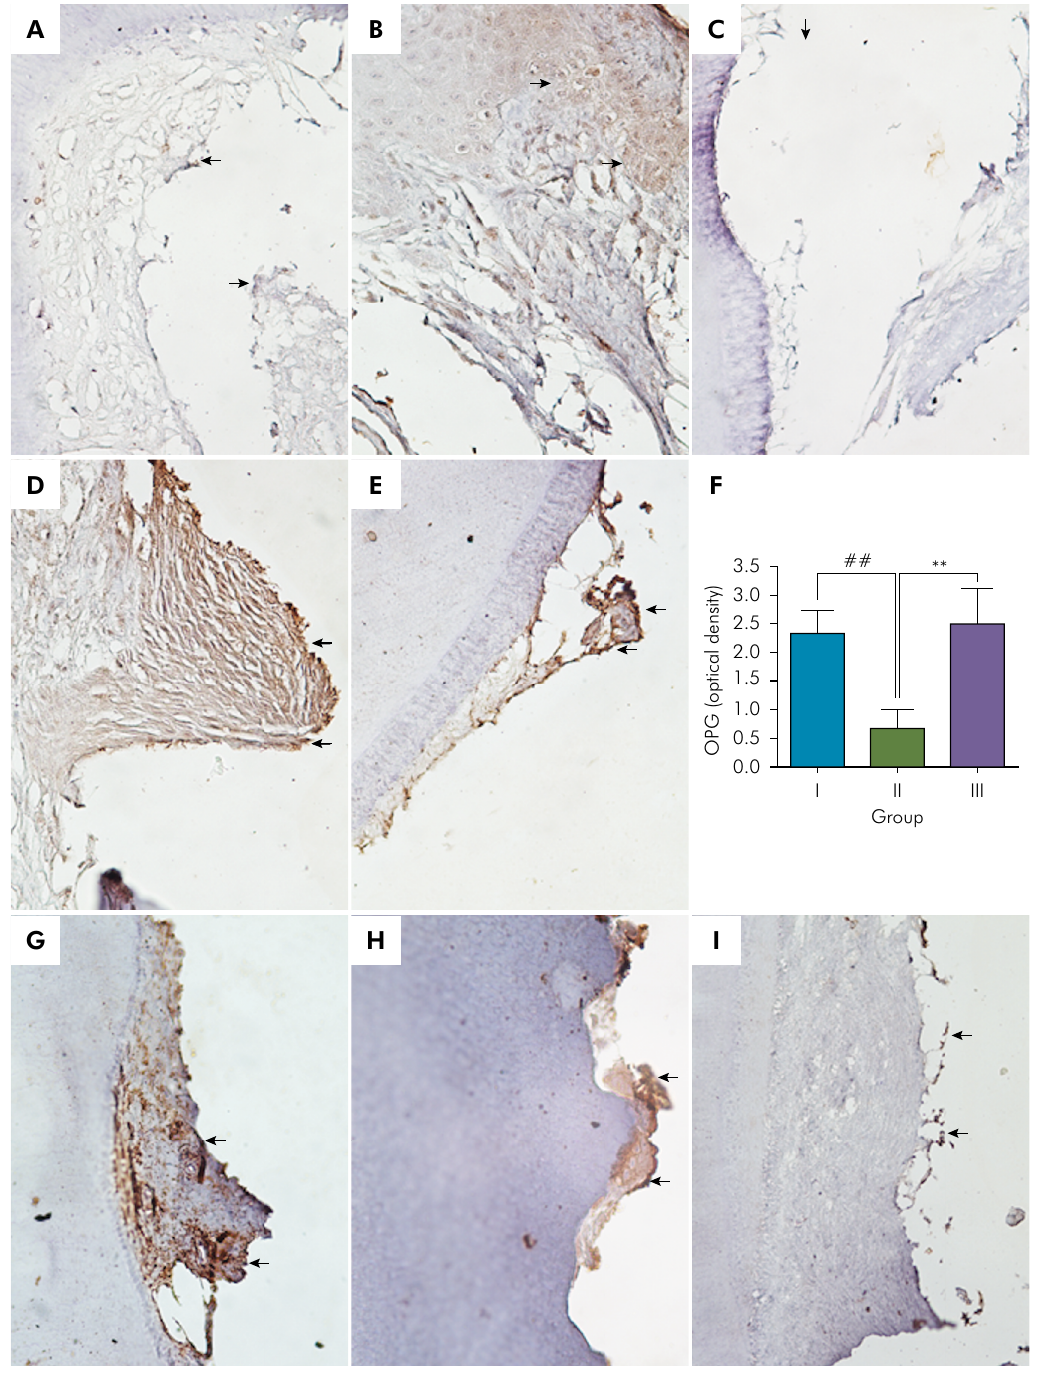
Figure 4. Expression of OPG and RANKL in PDL of human deciduous and permanent teeth; (A) labelling of OPG in PDL of areas of resorption of root surface in apical fragment and (B) cervical fragment in Group I revealing greater expression in cervical fragment (magnification: 400x); (C) absence of OPG expression in PDL in Group II (magnification: 400x); (D) strong expression of OPG in PDL in Group III (magnification: 400x); (E) graph comparing optical density in OPG expression among groups; (F) clear expression of RANKL in PDL of apical fragment in Group I, but to lesser degree in comparison to (G-H) resorption area of apical fragment in Group II (magnification: 400x); (I) minimal RANKL expression in PDL of permanent molar (magnification: 400x); (J) comparison of RANKL expression in periodontal tissue in different groups; data expressed as mean ± SEM of 10 teeth/group; #p < 0.05 and ##p < 0.001 versus Group I; **p < 0.001 versus Group II; ΔΔ P < 0.001 versus Group III (one-way ANOVA, followed by Student-Newmann-Keuls post hoc tests; immunohistochemical analysis from A to D and F to